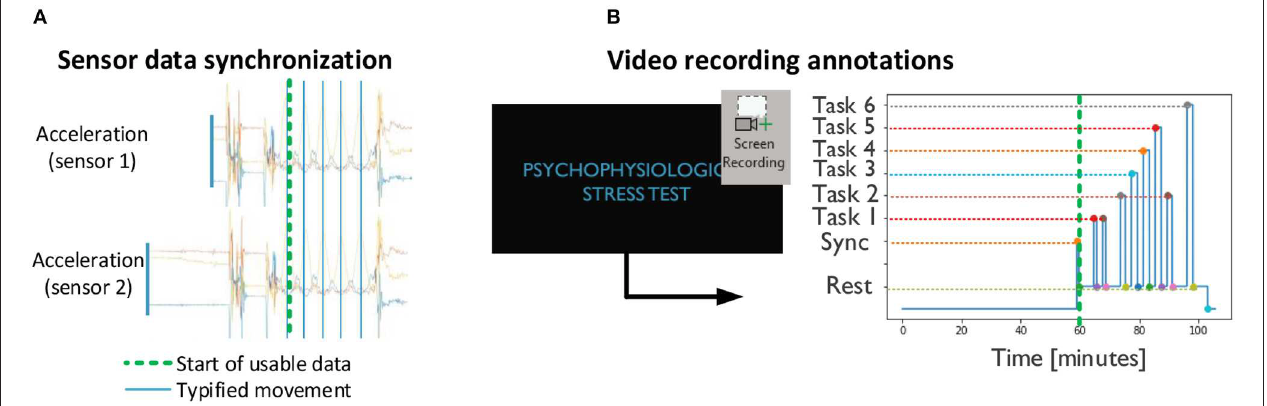
FIGURE 5 | Preliminary procedures: (A) synchronization across devices based on acceleration and (B) annotation of stress task events based on screen recordings. (A,B) are combined according to the sync point (green dashed